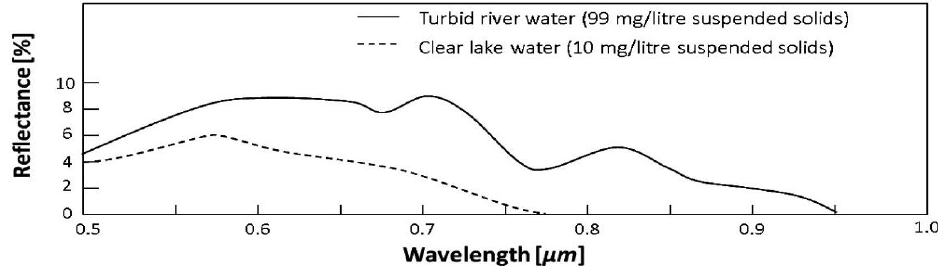
Figure 4. Spectral reflectance characteristics of clear and turbid water within the visible and near-infrared spectral range (0.5–1.0 μm) (Adapted from Davis et al.